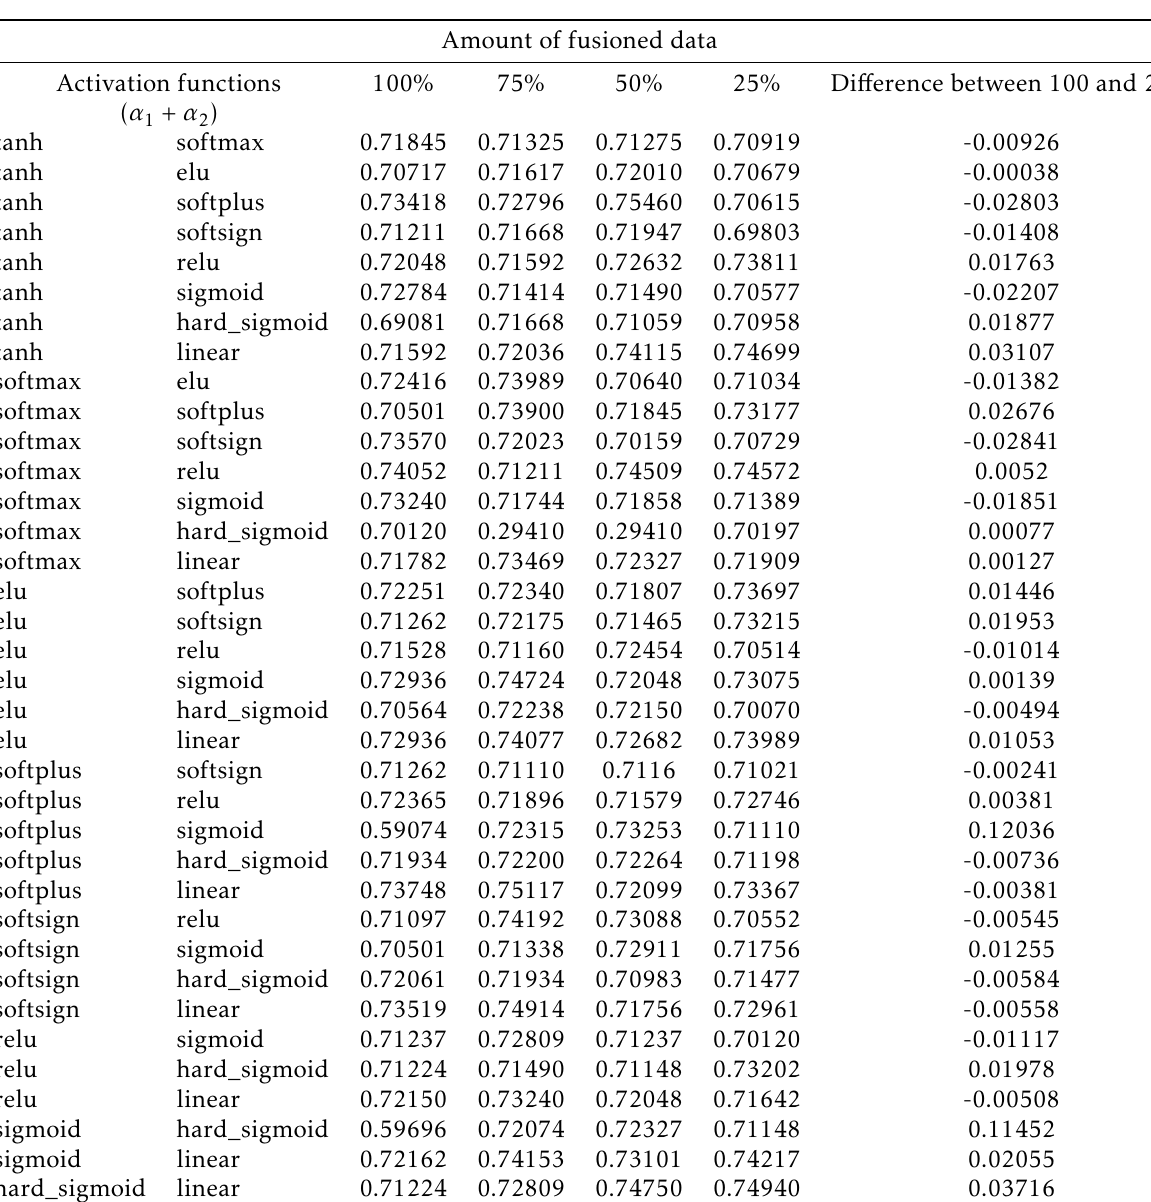
Table 2. Full results of the tuples for the activity recognition models for Subject 2. Complementary information of Table